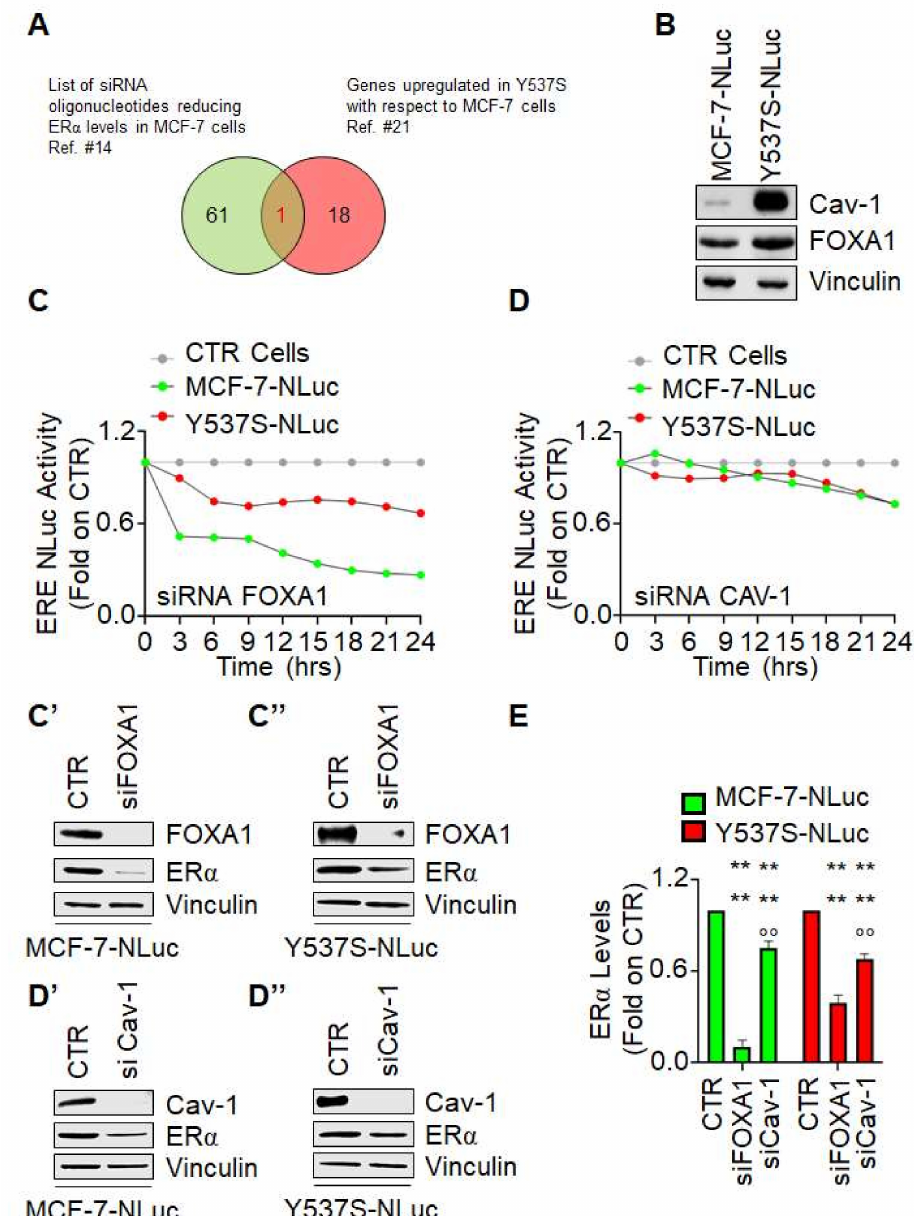
Figure 4. Sensitivity of Y537S NLuc cells to FOXA1 and caveolin-1 depletion. ( A ) Venn diagram indicating the dataset used to select caveolin-1 for further analysis. ( B ) Western blotting analyses of FOXA and caveolin-1 (Cav-1) expression in MCF-7-NLuc and Y537S-NLuc cells. Profile of ERE-NLuc activity detected in MCF-NLuc and Y537S-NLuc cells treated with siRNA oligonucleotides against FOXA1 ( C ) and caveolin-1 ( D ) in the presence of the live-cell substrate Nano-Glo ® EndurazineTM. Released light units (RLU) were measured for 24 h every other 5 min in a 37 ◦ C and 5% CO 2 -controlled atmosphere. Graphs show the compound effect calculated every other 3 h with respect to its relative control sample. The data are the means of two different experiments in which each sample was measured in triplicate (for details please see the material and method section). Western blotting analyses of ER α and FOXA1 expression in MCF-7-NLuc ( C (cid:48) ) and Y537S-NLuc cells ( C” ). Western blotting analyses of ER α and caveolin-1 (Cav-1) expression in MCF-7-NLuc ( D (cid:48) ) and Y537S-NLuc ( D” ) cells. ( E ) ER α densitometric analyses of the blots depicted in ( C (cid:48) – D” ). Significant differences with respect to the CTR sample were determined by unpaired two-tailed Student’s t -test: **** p < 0.0001. Significant differences with respect to the siFOXA1 sample were determined by unpaired two-tailed Student’s t -test: ◦◦ p <